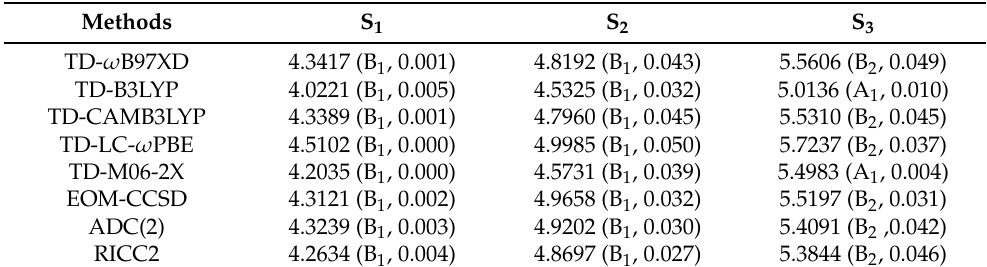
Table 1. Vertical excitation energies of C 7 H 4 computed using different levels of theory. 6-311++G(d,p) is the basis set used for the TDDFT methods and cc-pVDZ is used for the wavefunction based methods. Methods S 1 S